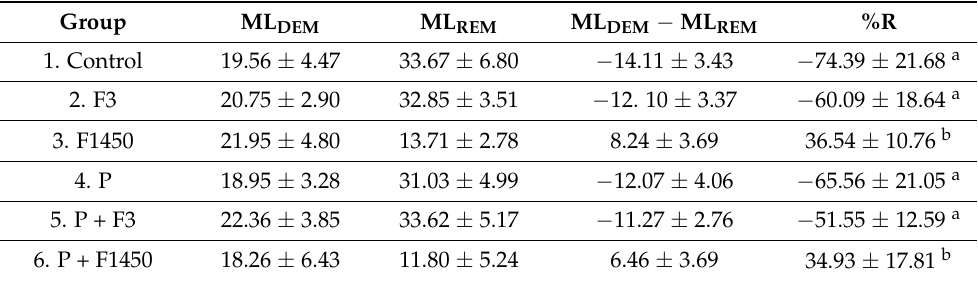
Figure 4. Mineral recovery rate of the six groups.